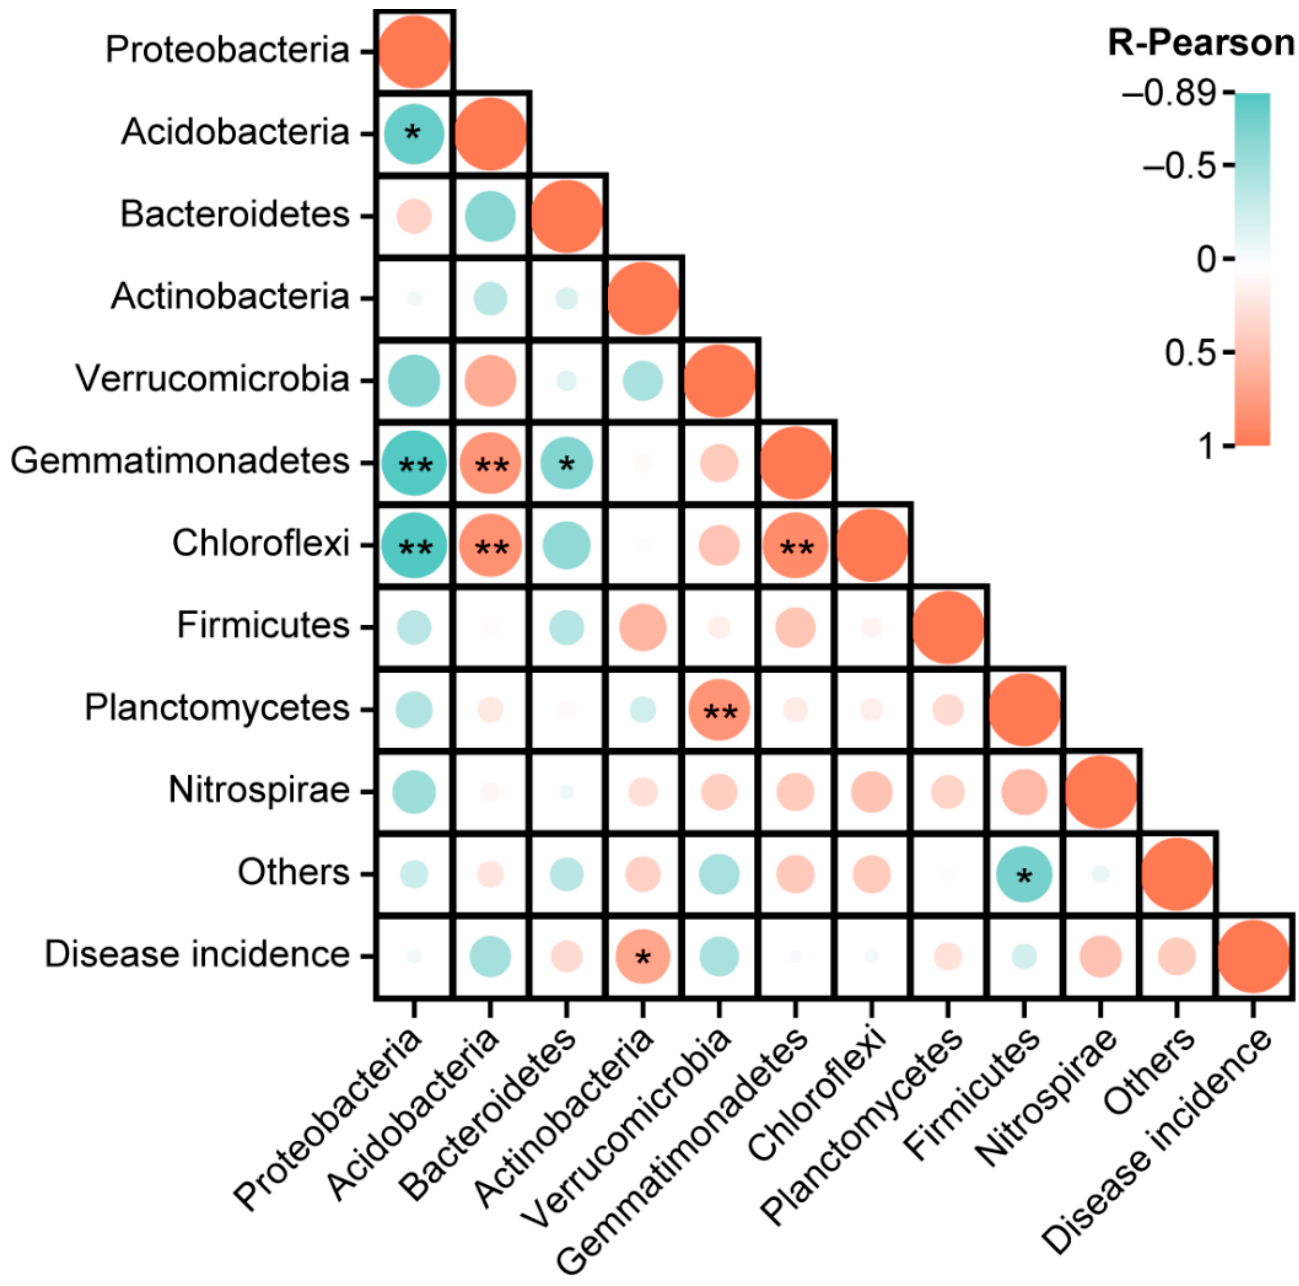
Figure 6. Pearson correlation analysis between the most abundant bacterial phyla and disease incidence. Pearson correlation coefficient ( p < 0.05). Asterisks represents the significant differences at * p < 0.05 and ** p < 0.01.